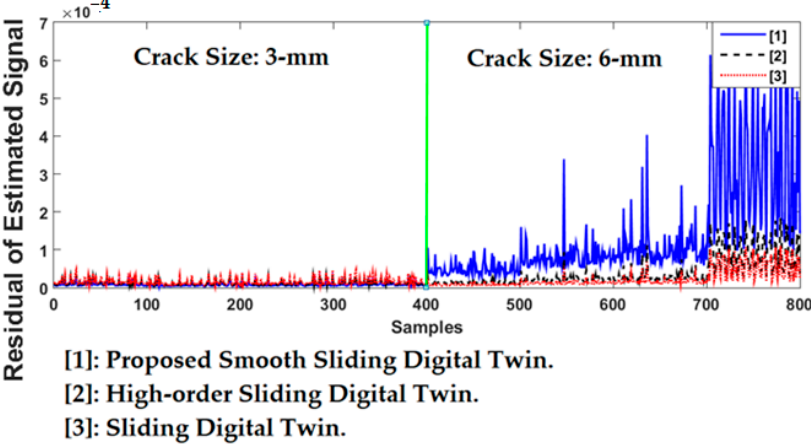
Figure 15. The accuracy of crack size identification for ball residual of RMS signals using proposed smooth sliding digital twin, high-order sliding digital twin, and sliding digital twin.